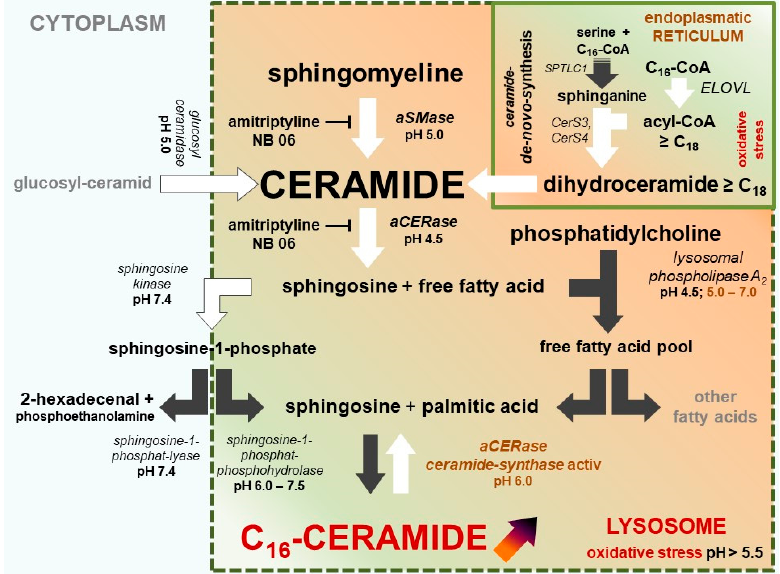
Figure 3. Ceramide metabolism and selective C 16 -ceramide synthesis in keratinocytes in atopic dermatitis lesions and sensitive / inflammatory skin (compartmentalized model of ceramide synthesis). Active pathways are marked with black arrows, less active and inactive pathways are marked with white arrows. Oxidative stress in keratinocytes results in the dysfunction of lysosomal V-ATPase. Ceramide hydrolase activity of acidic ceramidase (aCERase) loses activity and becomes inactive. In